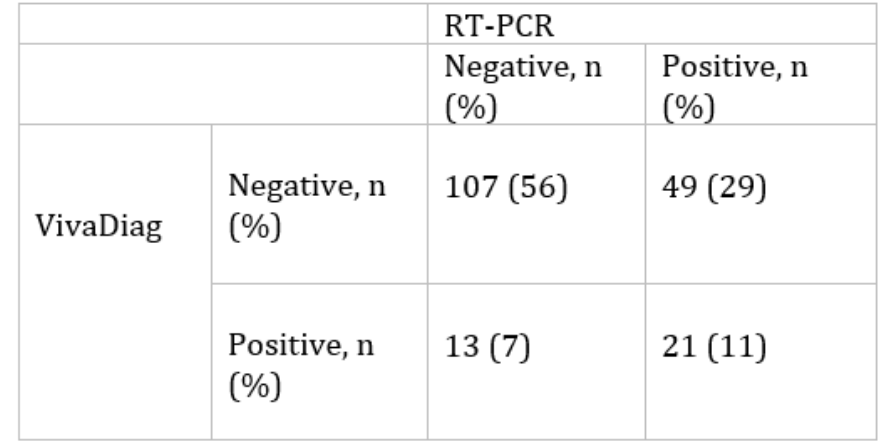
Figure 1. Comparison of RT-PCR and VivaDiag results from a series of 191 subjects ( P =.001). Compared to RT-PCR, VivaDiag had a sensitivity of